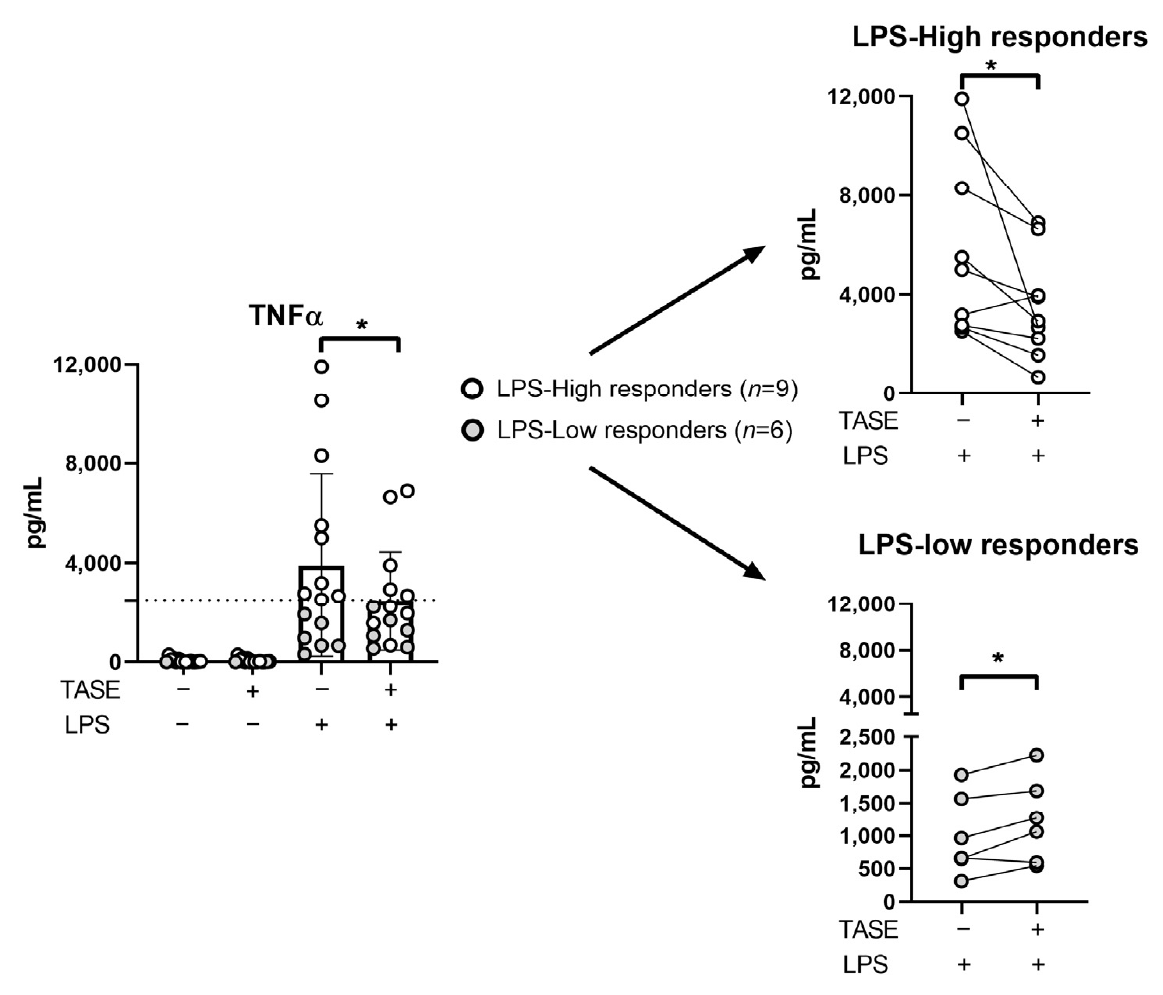
Figure 3. Comparison of thiosulfinate-enriched Allium sativum extract (TASE) effects in LPS response of low- and high-responder monocytes. Monocytes from HV ( n = 15) were stimulated with 10 ng/mL of LPS for 16 h in combination or not with 3 µ g/mL of TASE. The HV cohort was split into two groups according to the LPS response of their monocytes (cut-off 2500 pg/mL of TNF- α ). TNF- α levels in cell culture supernatant are shown. *, p < 0.05 in paired t test. White dots represent individual high responders values and grey dots individual low responders values. Left panels show paired analysis of individual values and bars express mean ± SD.